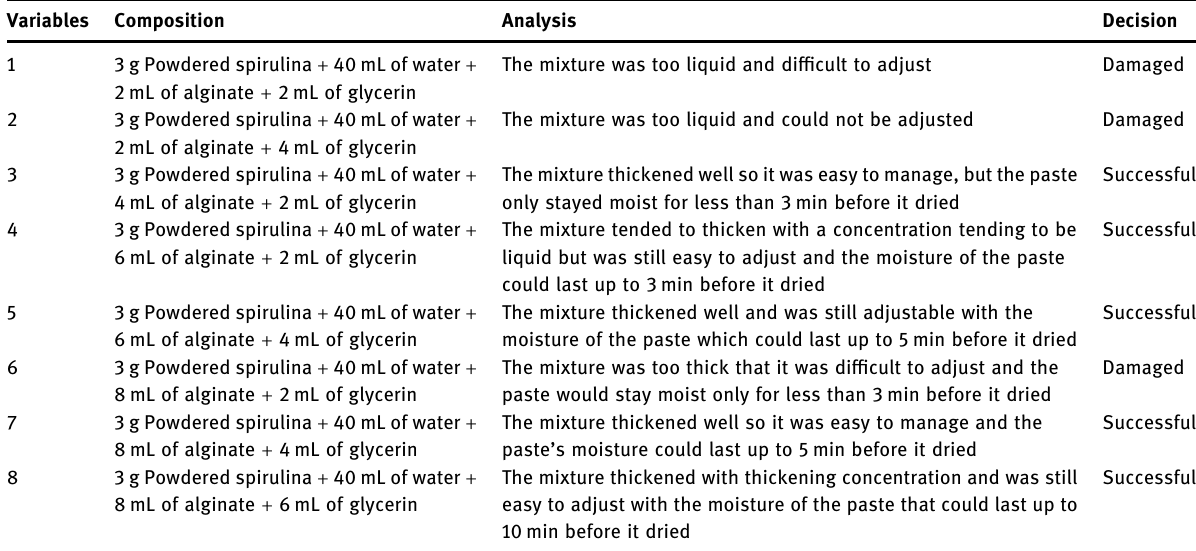
Table 4: Result of experiment of making Spirulina platensis natural coloring paste Variables